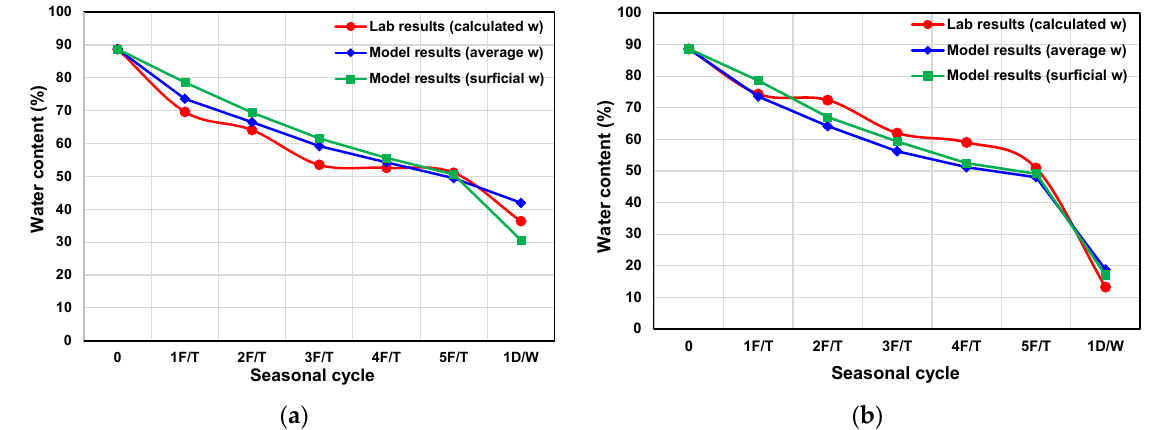
Figure 9. First ‐ phase testing comparisons: Water content values per seasonal cycle for the centrifuged tailings samples under a temperature gradient of ( a ) 0.083 °C/mm and ( b ) 0.028 °C/mm.